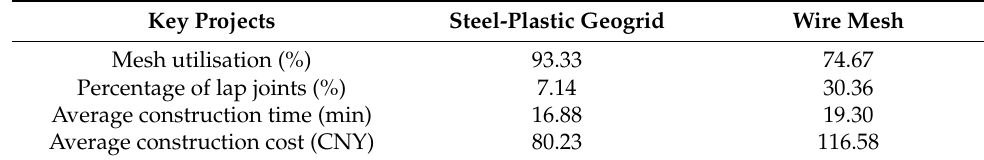
Table 8. Summary of key data from engineering trials.